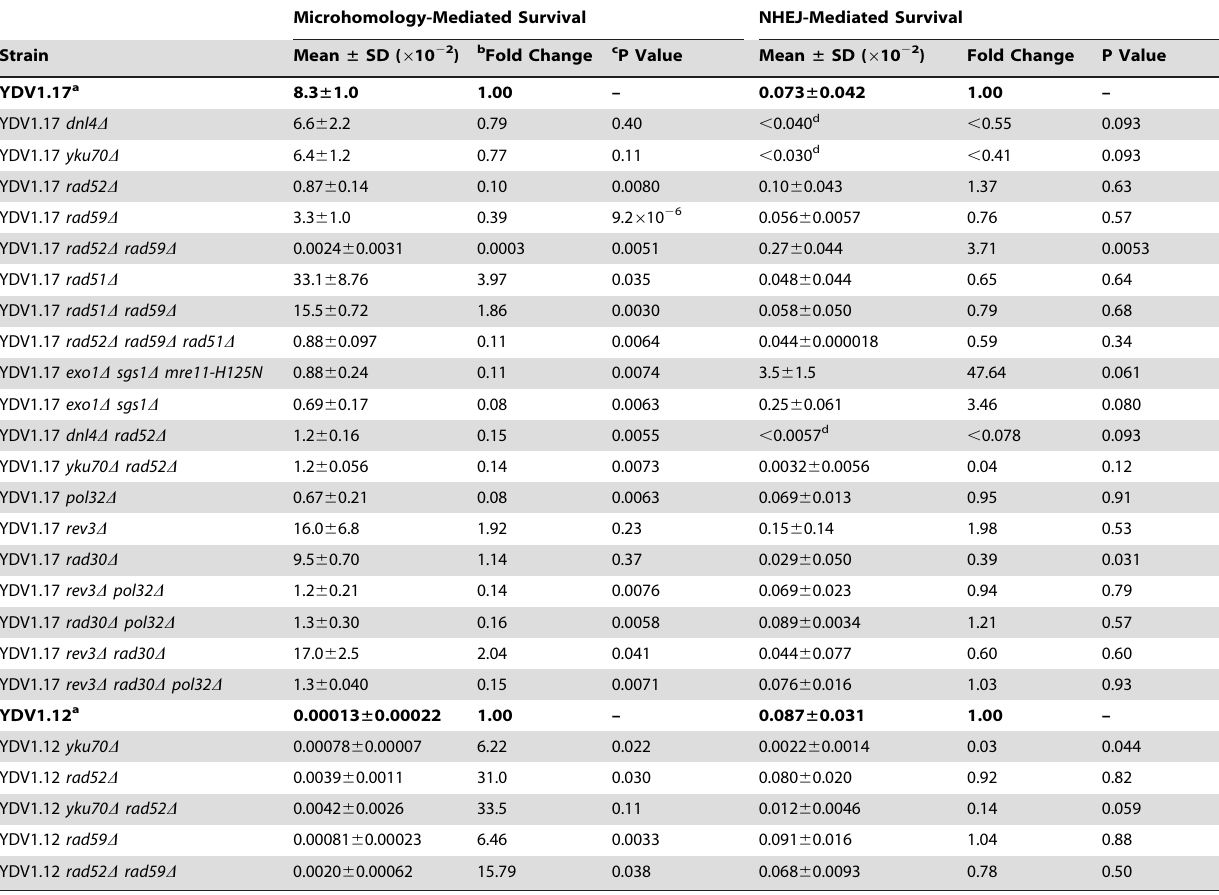
Table 1. Mutant strain survival